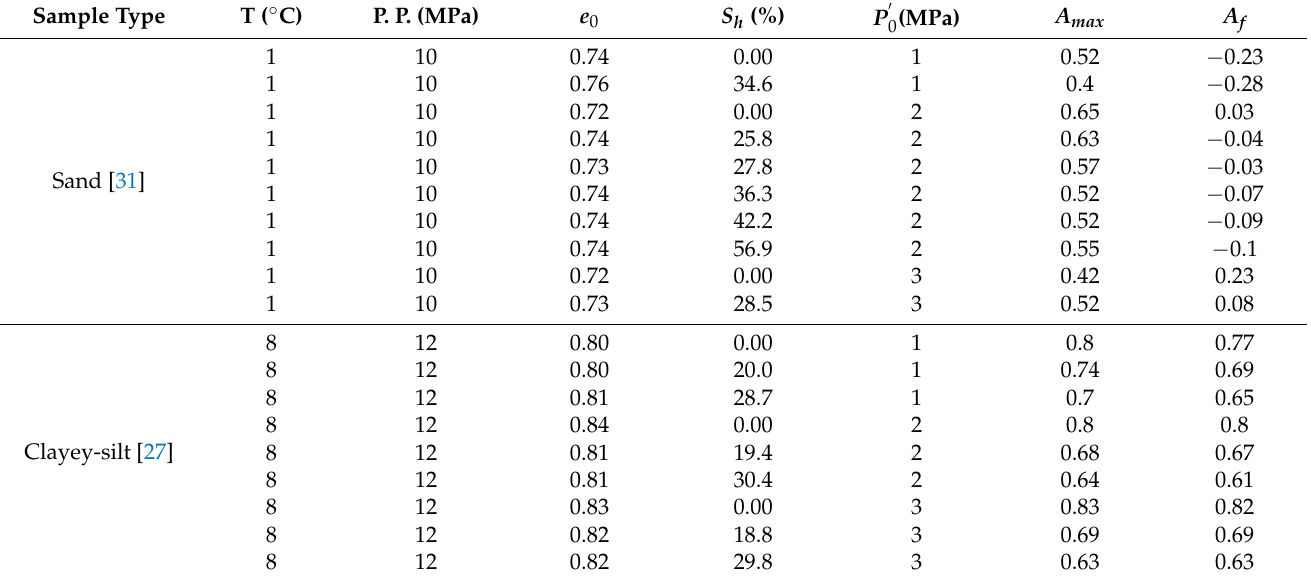
Table 1. Test conditions and results of undrained triaxial compression tests on different hydrate- bearing sediments. (Note. T: temperature, P. P.: pore pressure, e 0 : initial void ratio, S h : hydrate saturation, P (cid:48) : initial effective confining pressure, A f : pore pressure coefficient A at failure, A max : 0 maximum value of coefficient A